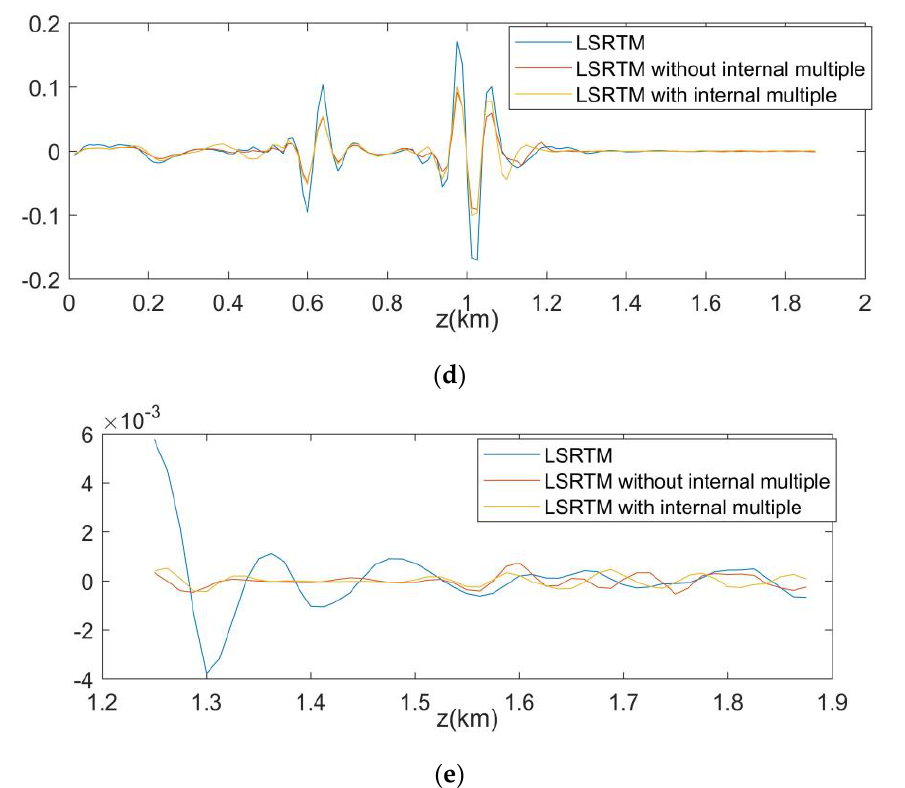
Figure 5. ( a ) LSRTM image. ( b ) RWLSRTM image of the primary. ( c ) RWLSRTM image of the primary and internal multiples. ( d ) the comparison of 150th trace ( e ) the comparison of 150th trace deeper than 1.25